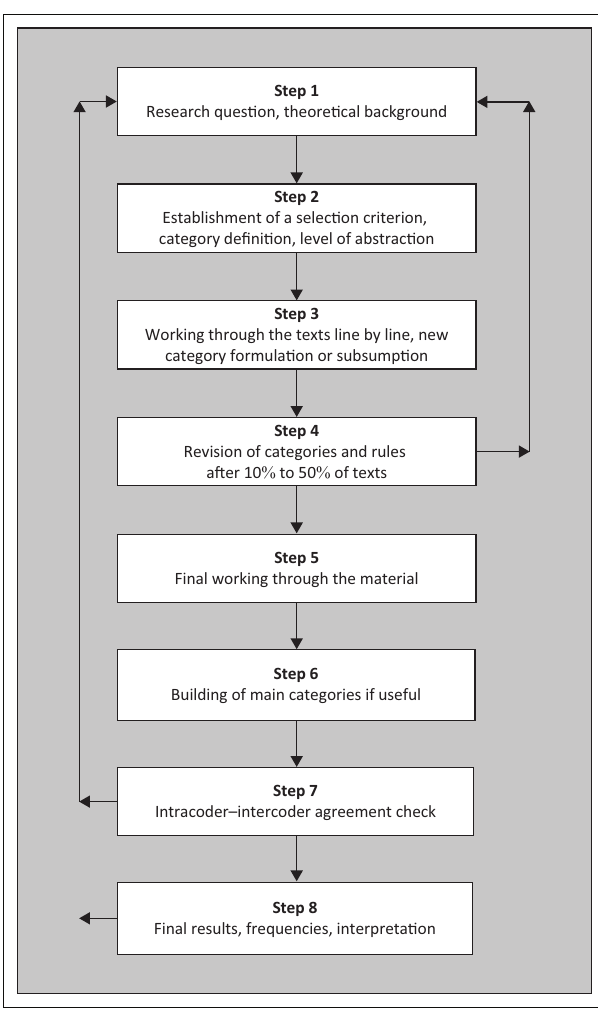
FIGURE 1: Steps of inductive category